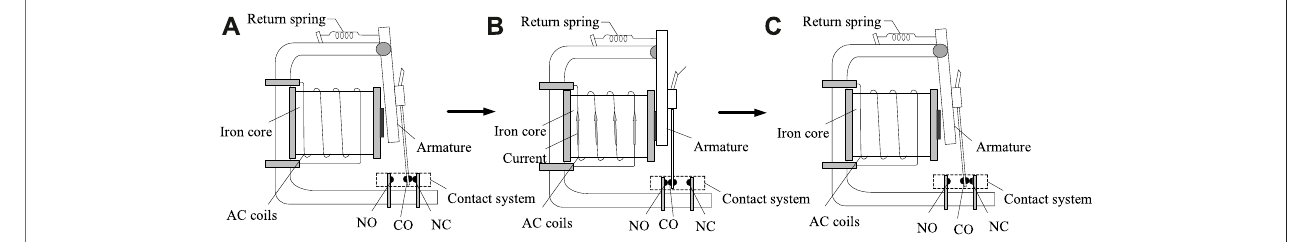
FIGURE 2 | Working principle of EMR. (A) EMR is not energized. (B) EMR is energized. (C) EMR is de-energized.